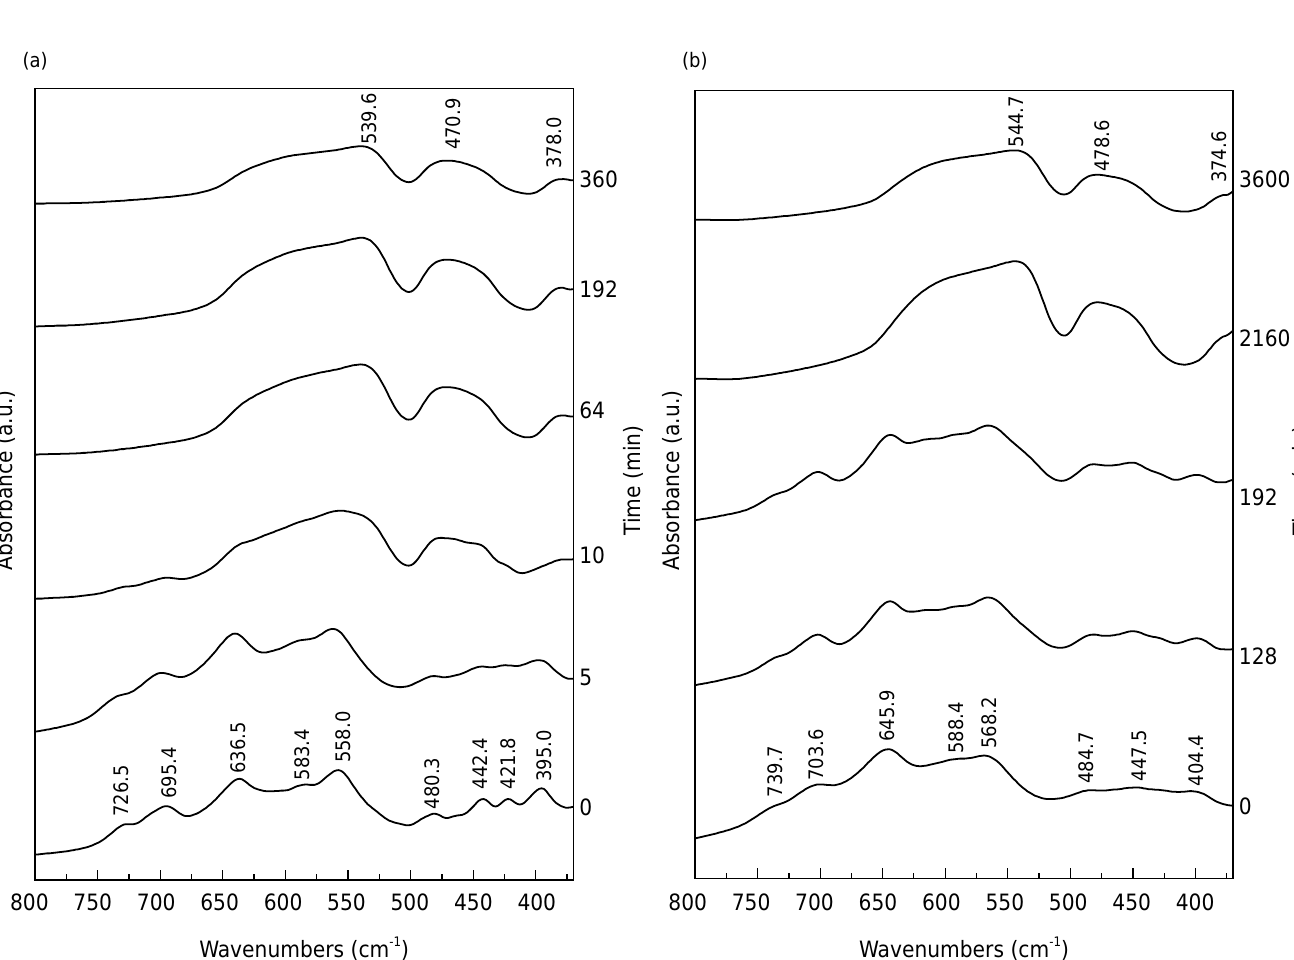
Figure 6. FTIR spectra of synthetic Al-substituted maghemite with 0.0 (a) and 12.0 (b) mol% Al in the range 370 - 800 cm -1 . a.u. = arbitrary